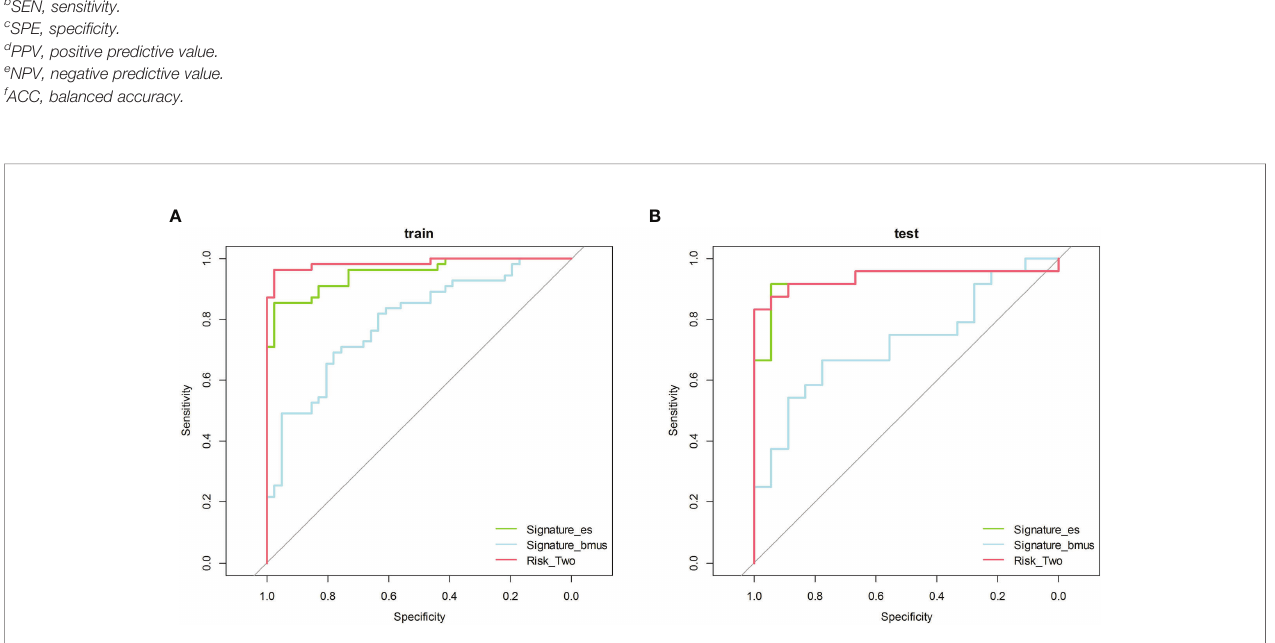
FIGURE 4 | The ROC curves of the three models. ROC, receiver operating characteristic. (A) Training cohort (B) Test cohort.